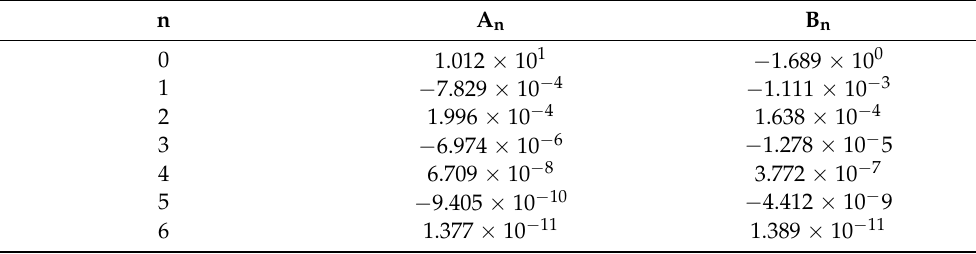
Table A17. Coefficients of the H 2 O-LiBr + LiNO 3 saturated pressure